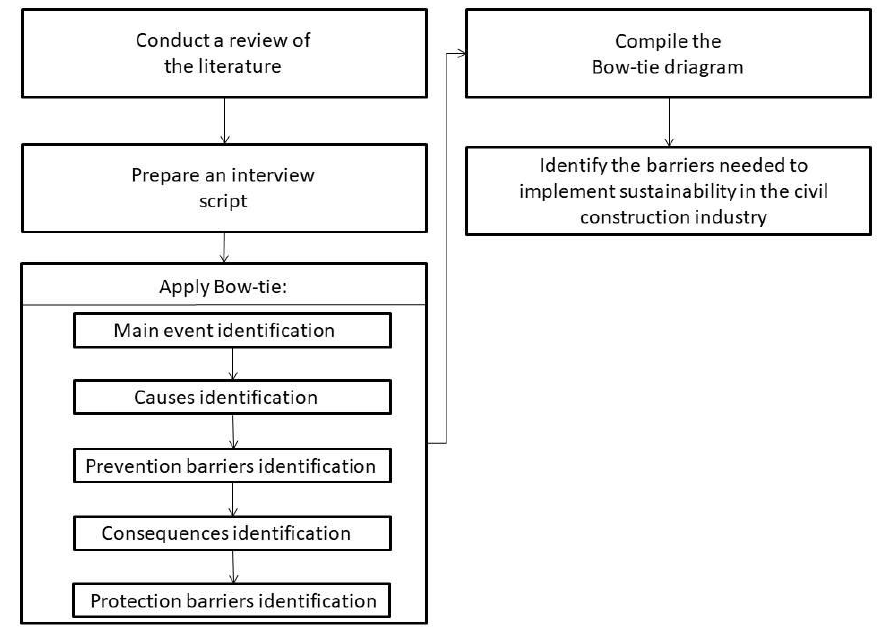
Figure Figure 1. Framework for identification of barriers to implement sustainability in the civil construction industry.